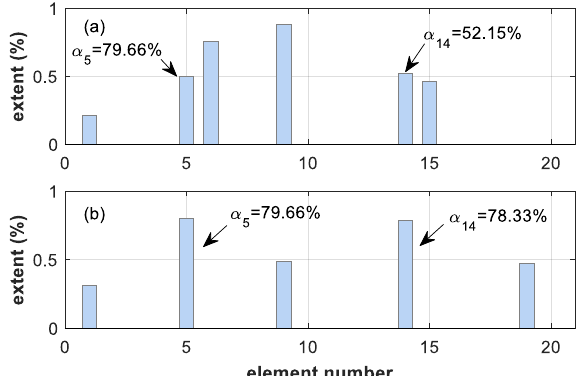
Figure 24. Damage identification results of damage case III, with an iterative Tikhonov solution: ( a ) CMSE method; ( b ) RCMSE method.